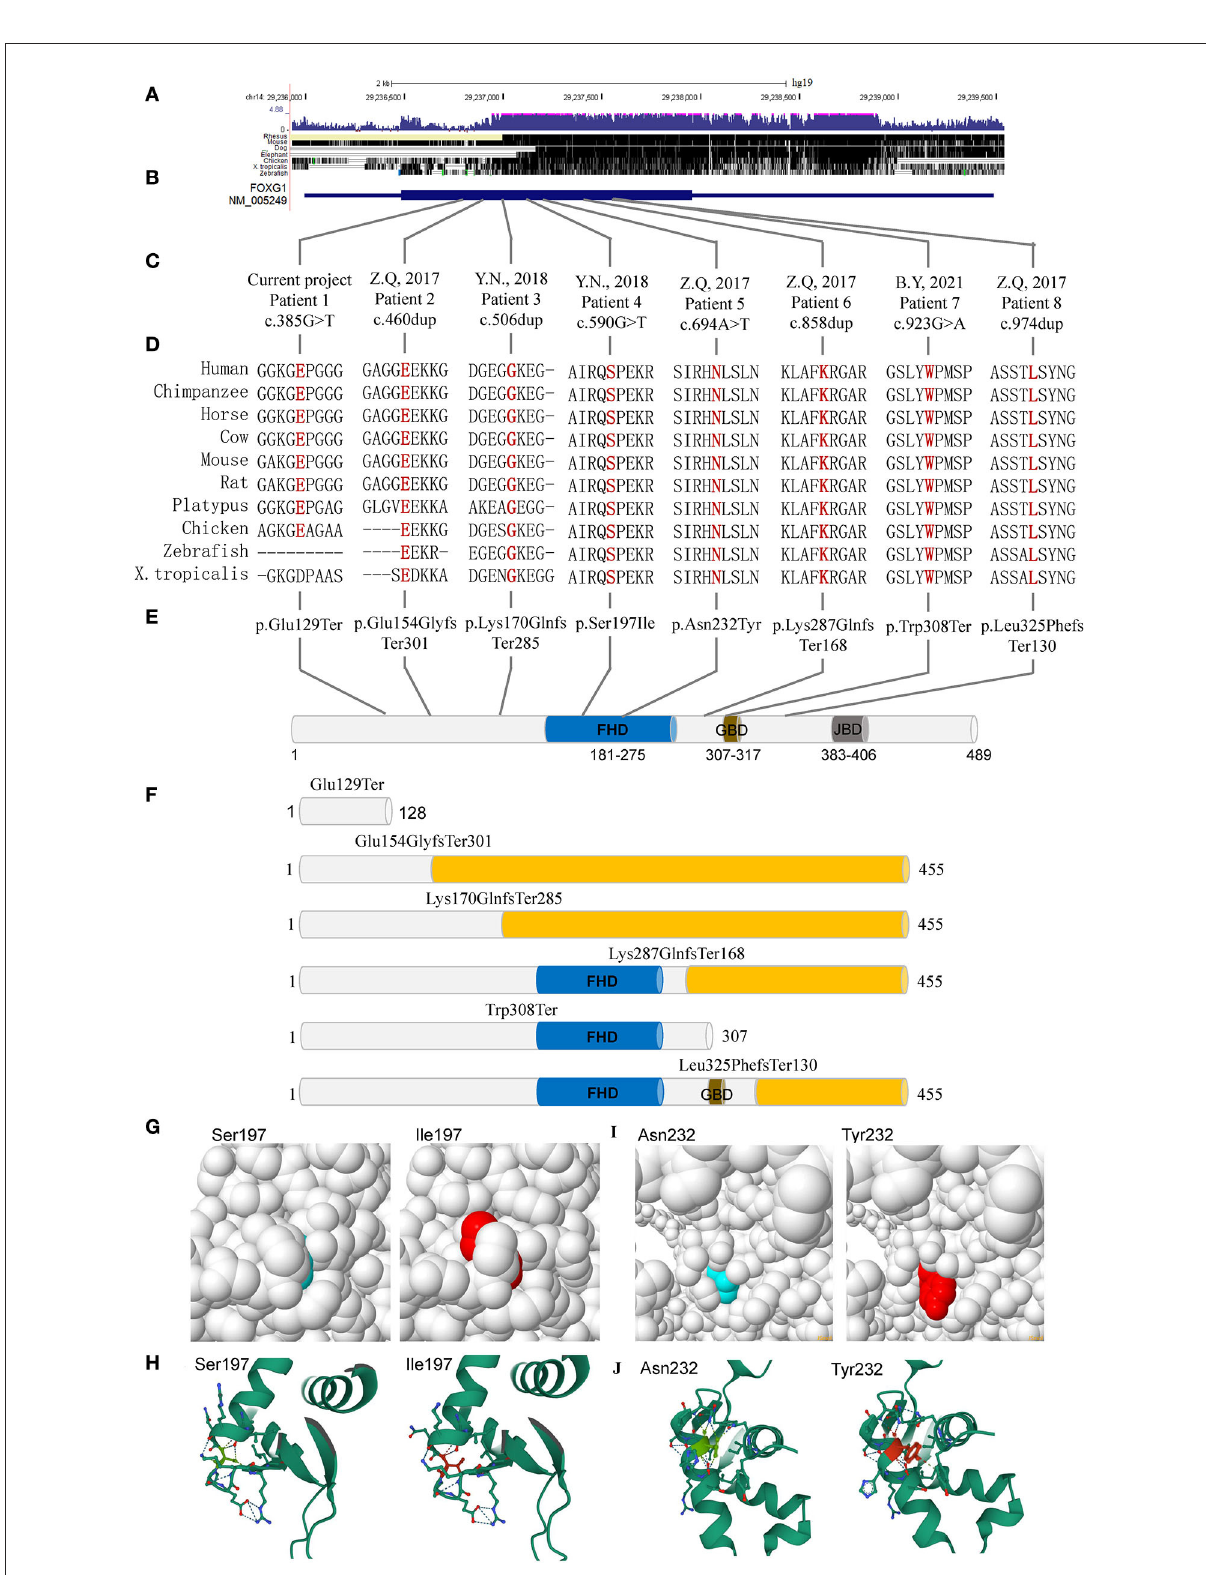
FIGURE3 Single-nucleotide mutations of FOXG1 identified in Chinese patients. (A) Conservation of the genomic region; (B) Gene structure of FOXG1; (C) Nucleotide changes of the mutations; (D) Conservation analysis of the mutations; (E) Amino acid changing of the mutations; (F) Proteins containing truncating mutations. (G) Structure of FHD domain with Ser197; (H) Structure of FHD domain with Ile197; (I) Structure of FHD domain with N232; (J) Structure of FHD domain with Y232. FHD, DNA binding fork-head domain; GBD, Groucho-binding domain; JBD, JARID1B binding domain. The yellow cylinder represents the aberrant amino acids caused by frameshifting